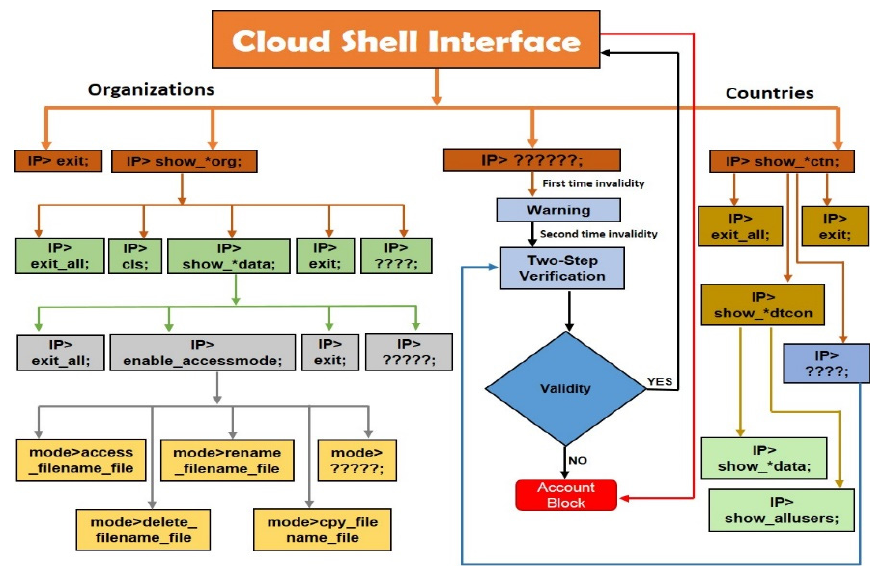
Figure 7. Cloud Shell Interface queries (* Show all organizations).